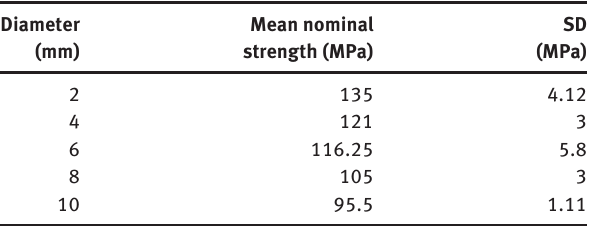
laminates open hole. 2s